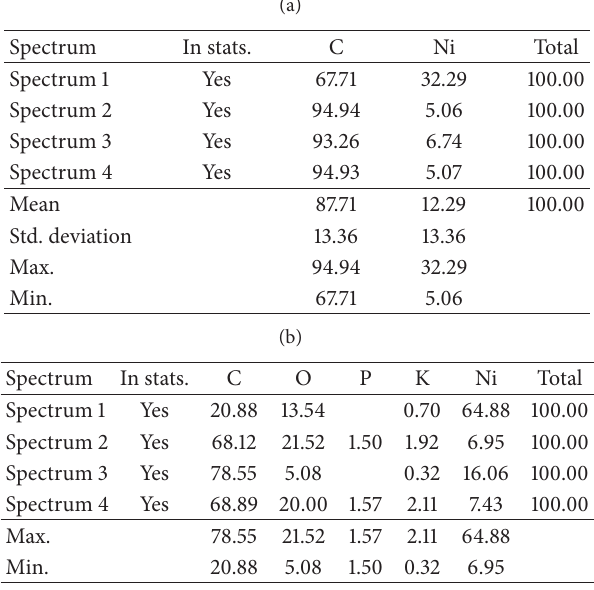
Table 3: The elemental profile of the SWCNT/Ni nanofilm deposited on the BPPGE surface (a) before and (b) after